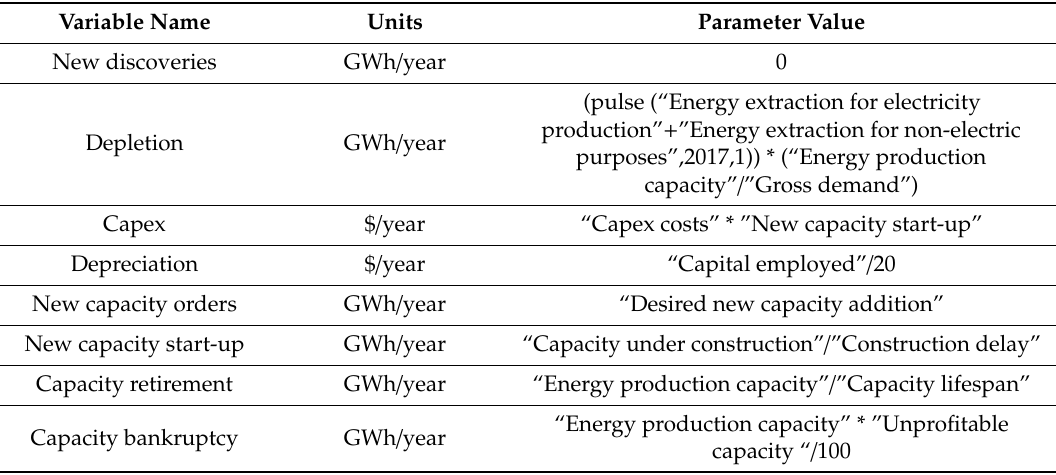
Table A2. Parameters used for flows.